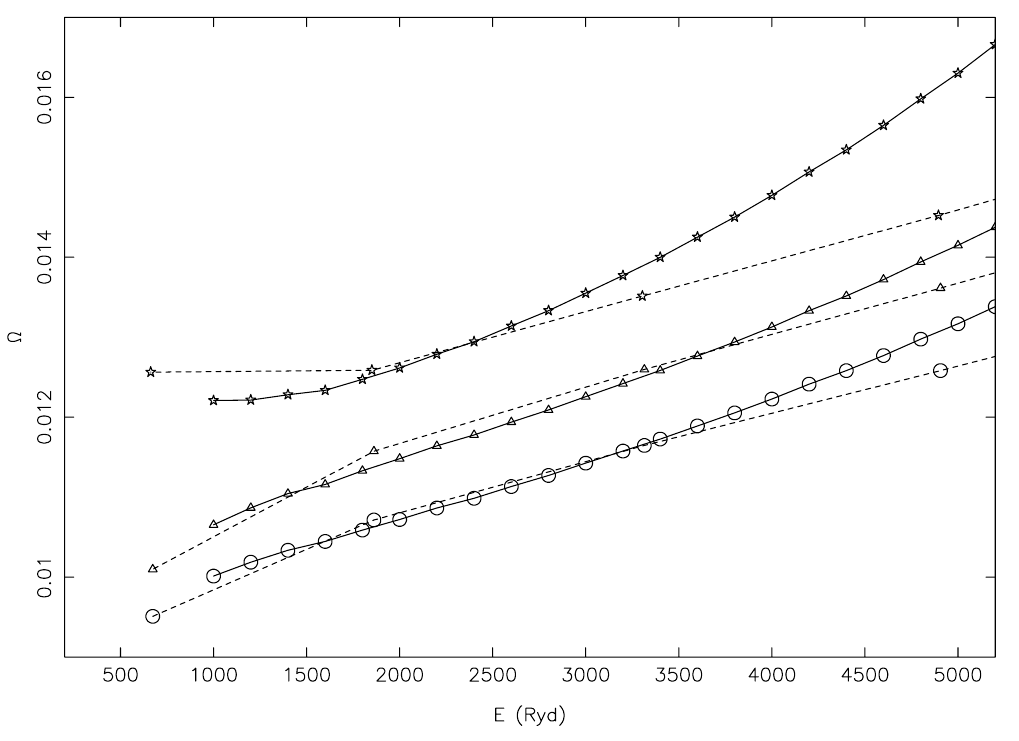
Figure 3. Comparison of collision strengths for the 4–16 (2s 2 2p 4 3s 4 P 5/2 –2s 2 2p 4 3d 4 D 5/2 : circles), transitions of W LXVI. Continuous curves: present results from DARC, broken curves: present results from